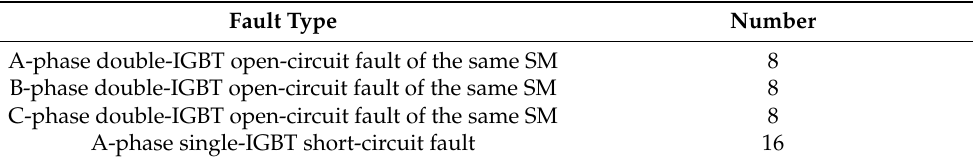
Table 8. Fault types.